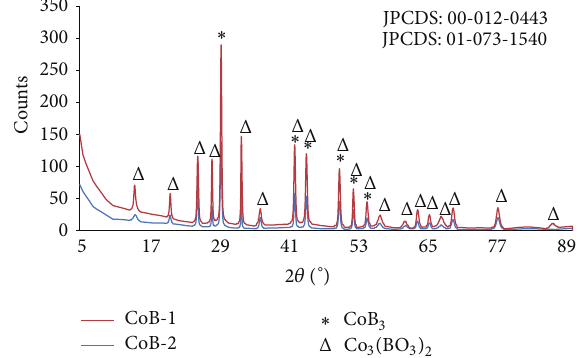
Figure 3: The XRD patterns of Co-B